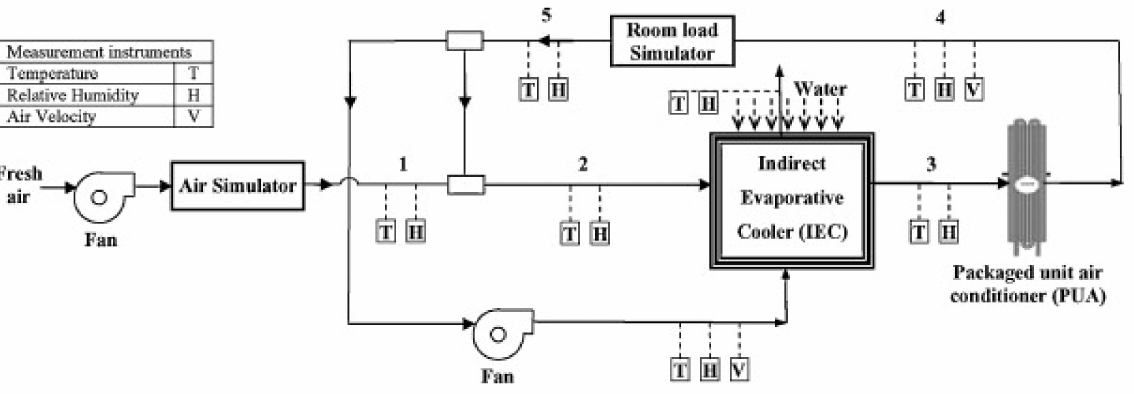
Figure 9. Experimental setup of hybrid IEC-PUA system. Reprinted with permission from Ref. [55]. Copyright 2019, Elsevier.